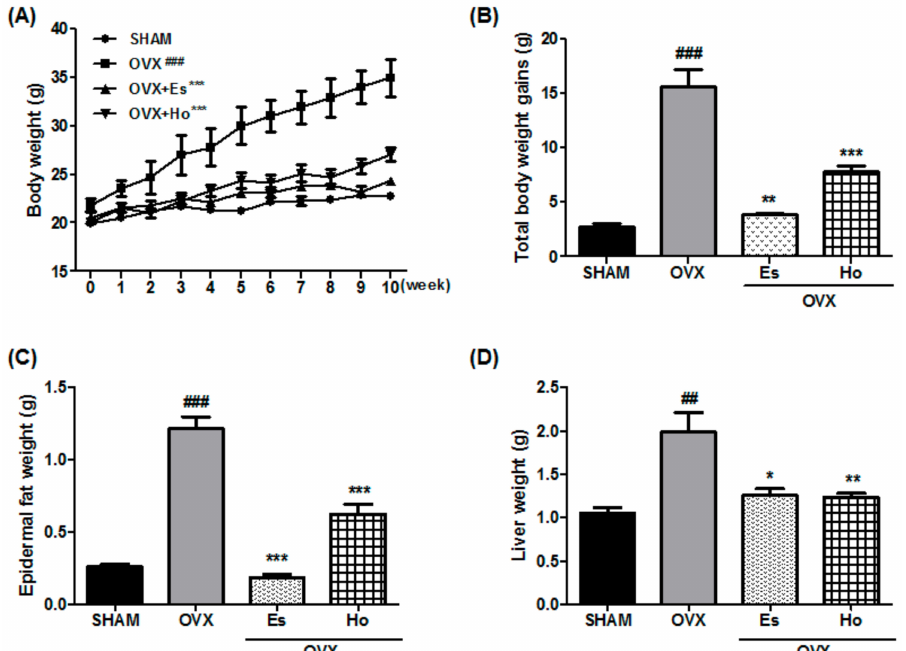
Figure 1. Honokiol reduces bodyweight, epidermal fat and liver weight. Data were determined after 11 weeks of administration with Honokiol, estradiol in female OVX mice. Body weight ( A ) and total body weight gain ( B ) change at 2 weeks after operation. Epidermal fat ( C ) weight and liver weight ( D ) changed after the administration of Honokiol and estradiol after OVX. Data shown are means ± standard error of mean (SEM). * p < 0.05, ** p < 0.01 and *** p < 0.001 vs. OVX-operated group. ## p < 0.01 and ### p < 0.001 vs. sham-operated group. OVX, ovariectomy; Es,